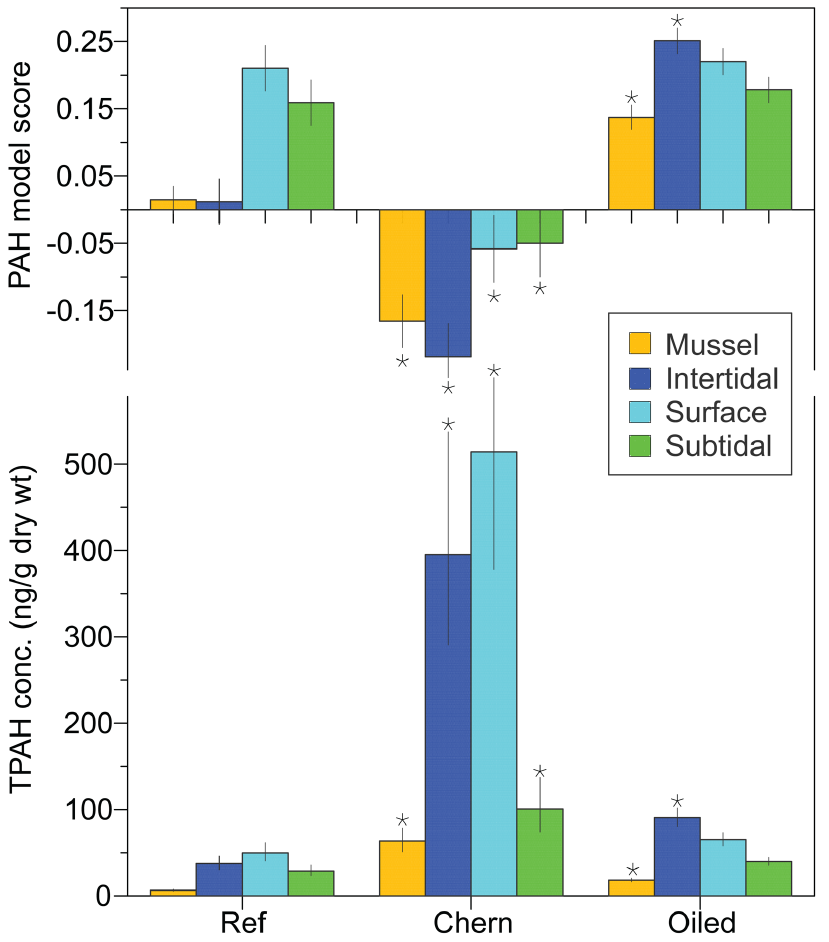
Fig 5. Mean TPAH and PAH model scores in mussels and PEMDs by area [reference (ref), Chernofski Harbor (Chern), and oiled] and zone (subtidal, surface water, and intertidal). Potential PAH model scores range from -1 (pyrogenic) to +1 (petrogenic); scores close to 0 indicate ambiguous sources. Error bars are ± SE. Statistically significant results (versus reference values) are indicated with asterisks. Samples were collected in